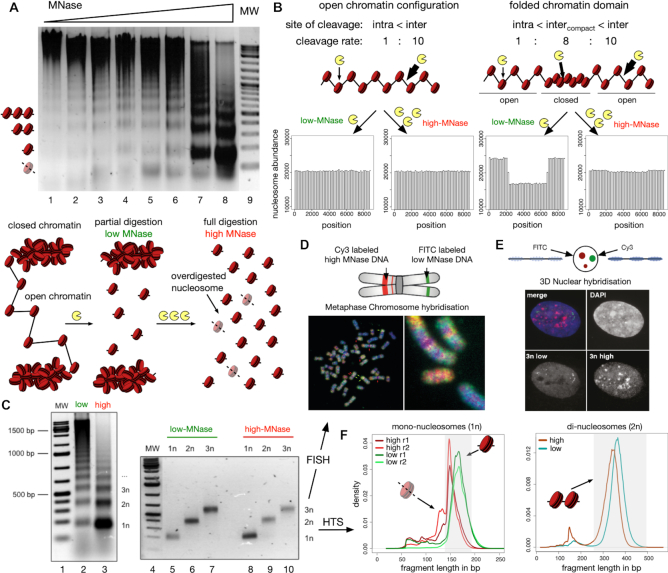
Isolation of nucleosomal DNA after differential MNase hydrolysis. (A) Nucleosomal DNA ladder of HeLa cells incubated with increasing concentrations of MNase. The agarose gel is showing the analysis of the purified DNA after MNase hydrolysis. The molecular weight marker is shown in lane 9 and the positions of subnucleosomal, mono-, di- and tri-nucleosomal DNA are indicated. The scheme below illustrates the hypothetical results of a partial and full hydrolysis of differentially accessible chromatin domains. (B) Simulation of low- and high-MNase digestions (see Materials and Methods for details) of an equally accessible linker DNA with pcut(linker) = constant (left panel) and of a nucleosomal array containing a central compacted chromatin domain with reduced linker accessibility pcut(linker, compact) = 0.8·pcut(linker), (right panel). The relative sensitivity of intra-nucleosomal (intra) and inter-nucleosomal (inter) cleavage is indicated. (C) Large scale low- and high-MNase hydrolysis of chromatin (lanes 2 and 3) and subsequent isolation of nucleosomal DNA corresponding to the mono-, di-, and tri-nucleosomes (lanes 5 to 10). (D, E) 2D and 3D FISH experiments with isolated tri-nucleosomal DNA. Metaphase FISH (D) and 3D FISH (E) were performed with Cy3/FITC labelled tri-nucleosomal DNA derived from high-/low-MNase digestions, as indicated. (F) Low- ad high-digested mono- and di-nucleosomal DNA were subjected to library preparation and high throughput sequencing. The fragment size distributions of the mapped paired-end reads for mono- (left panel) and di-nucleosomal DNA (right panel) are shown. The shaded boxes highlight the fraction of isolated mono-nucleosomal (140–200 bp) and di-nucleosomal (250–500 bp) fragments.